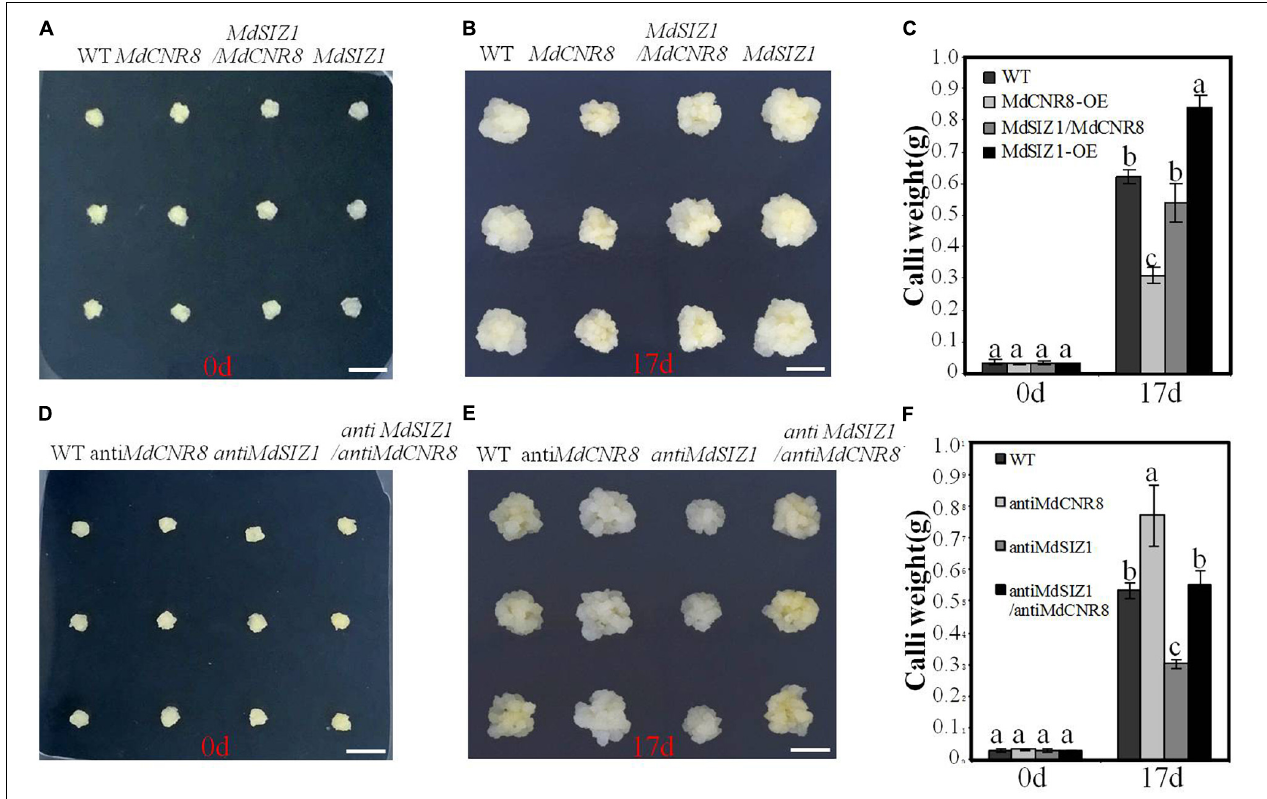
FIGURE 8 | MdSIZ1-mediated SUMOylation of MdCNR8 regulates cell proliferation and organ size in apple. (A–C) Phenotypes of the WT, MdCNR8 overexpression ( MdCNR8 ), MdSIZ1 overexpression ( MdSIZ1 ), and MdCNR8-OE/MdSIZ1-OE double overexpression ( MdSIZ1/MdCNR8 ) apple calli. Bars = 1 cm. The weight of 0-day-old calli and 17-day-old calli was measured and shown as averages ± SD ( n = 11 to 20). (D–F) Phenotypes of the WT, anti-MdCNR8, anti-MdSIZ1, anti-MdSIZ1/anti-MdCNR8 transgenic apple calli. Bars = 1 cm. The weight of 0-day-old calli and 17-day-old calli was measured and shown as averages ± SD ( n = 11 to 20). Different letters on each bar denote significant differences ( p < 0.01, ANOVA, Tukey’s correction).